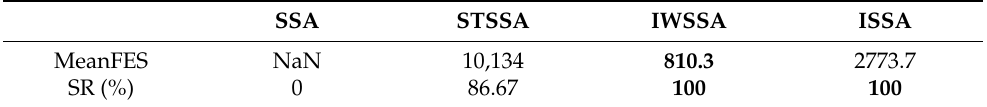
Table 4. MeanFES and SR